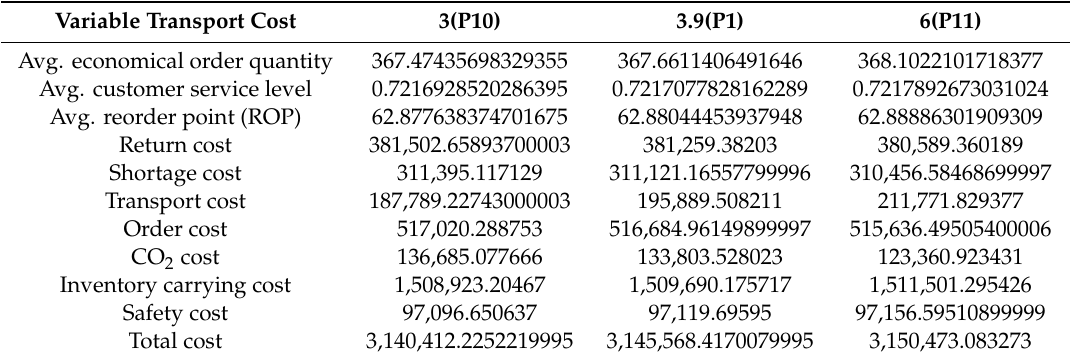
Table 18. The results of the sensitivity analysis for transport cost based on the ROPIRPSDRCO 2 mode. Variable Transport